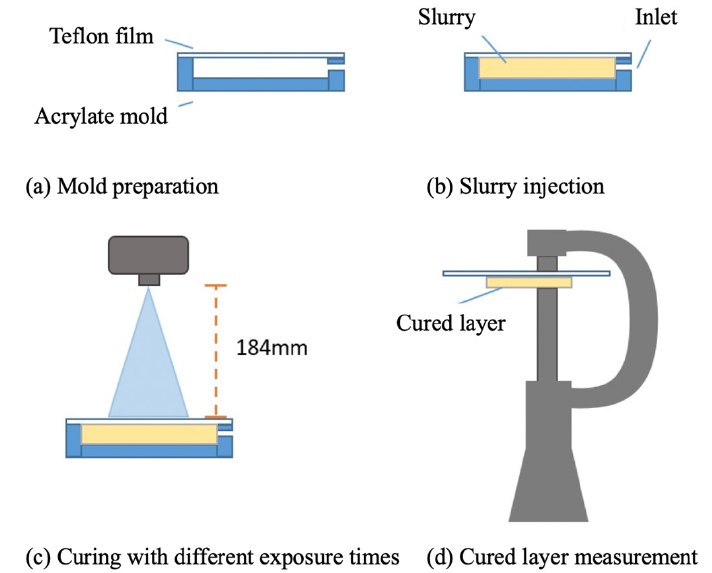
Figure 4. The measurement procedure for the slurry curing test. ( a ) Mold preparation; ( b ) Slurry injection; ( c ) Curing with different exposure times; ( d ) Cured layer measurement. injection; ( c ) Curing with different exposure times; ( d ) Cured layer